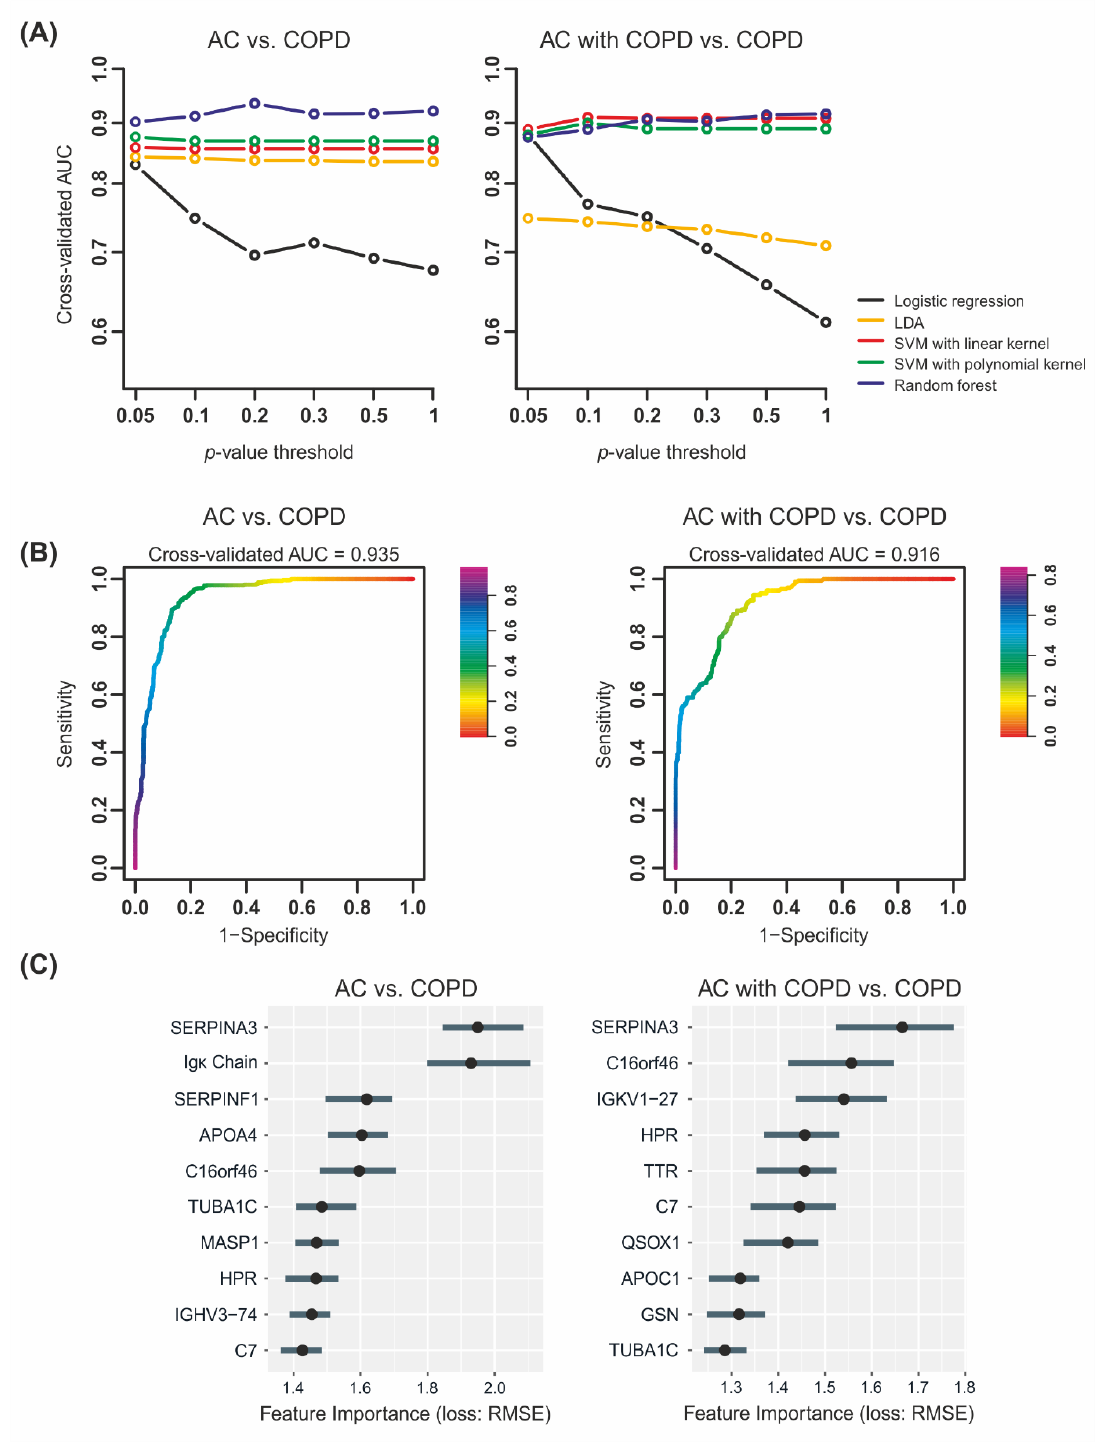
Figure 4. Results of machine learning approaches. ( A ) Five machine learning approaches were compared for classification of AC vs. COPD (left panel) and AC with COPD vs. COPD (right panel). Different p -value thresholds were assessed for feature selection and plotted against the respective ten- times-repeated 10-fold-cross-validated AUCs. ( B ) Receiver operating characteristic (ROC) curves for the best-performing random forest classifiers (AC vs. COPD: p -value threshold = 0.2; AC with COPD vs. COPD: no p -value threshold). ( C ) Feature importance plots illustrating the relative influence of individual proteins on multivariate classification models. Proteins represented by gene names (except Ig κ